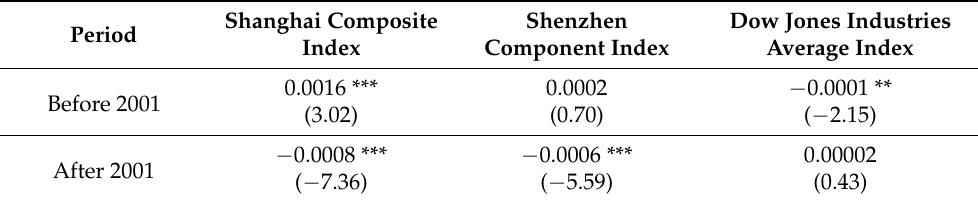
Table 9. Tests for overnight return before and after 2001. Table 9 shows the t -tests results of tests for the overnight returns of the Shanghai Composite Index and the Shenzhen Component Index before and after 2001. The year of 2001 is used as a milestone for internet development in China, and the sampling period is divided into two parts, before and after this year. Dow Jones Industries Average Index is used as a benchmark to compare with the overnight return in Chinese stock market. Shanghai Composite Shenzhen Dow Jones Industries Period Index Component Index Average Index 0.0016 *** 0.0002 Before 2001 (3.02) ( − 2.15) − 0.0008 After 2001